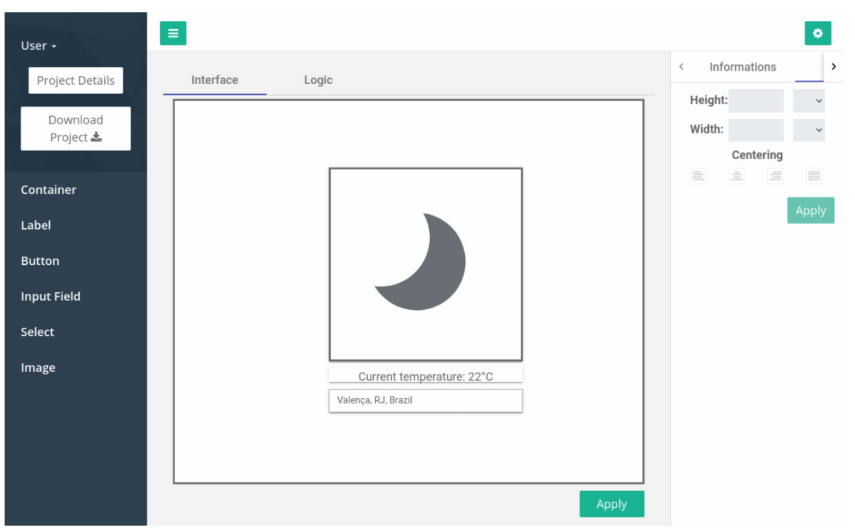
Figure 3. Interface creation screen for an application that pulls the temperature from a Website and displays its value on a canvas.